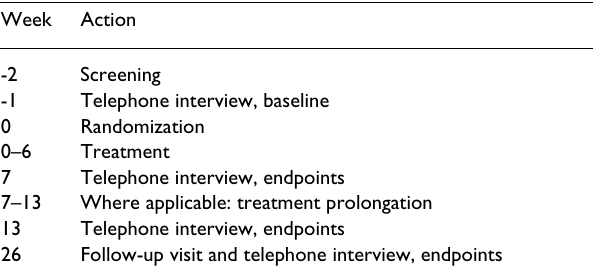
Table 2: Time schedule for each